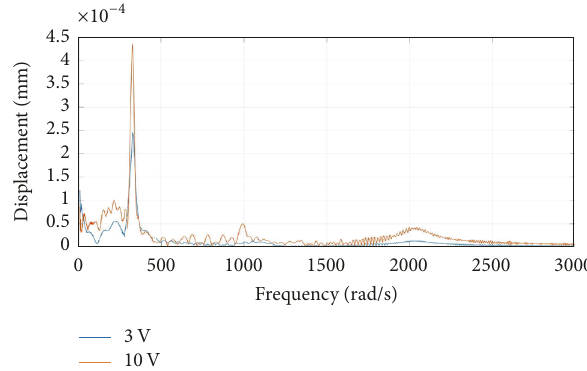
Figure 18: Experimental characterization of device natural frequencies for chirp signals of 3 V and 10V.